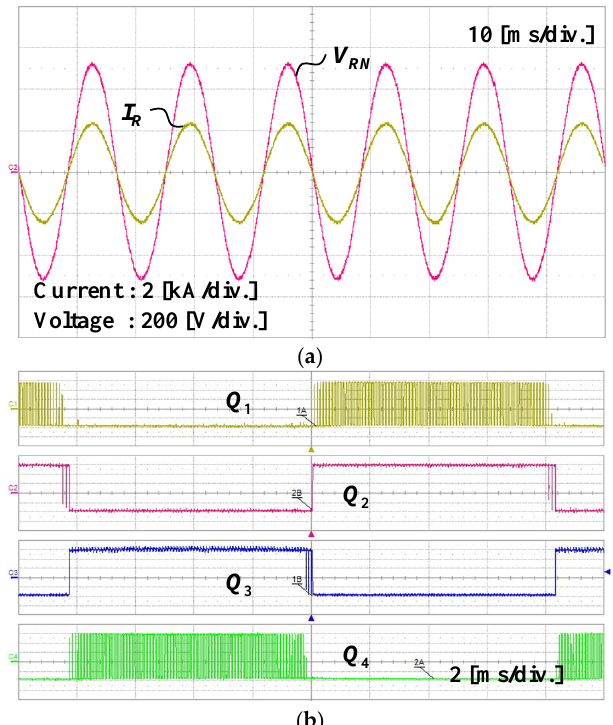
Figure 14. Experimental results in the case where the power factor is controlled at 1.0 using the proposed switching scheme: ( a ) waveforms of the output voltage and current; ( b ) waveforms of the gate signal.